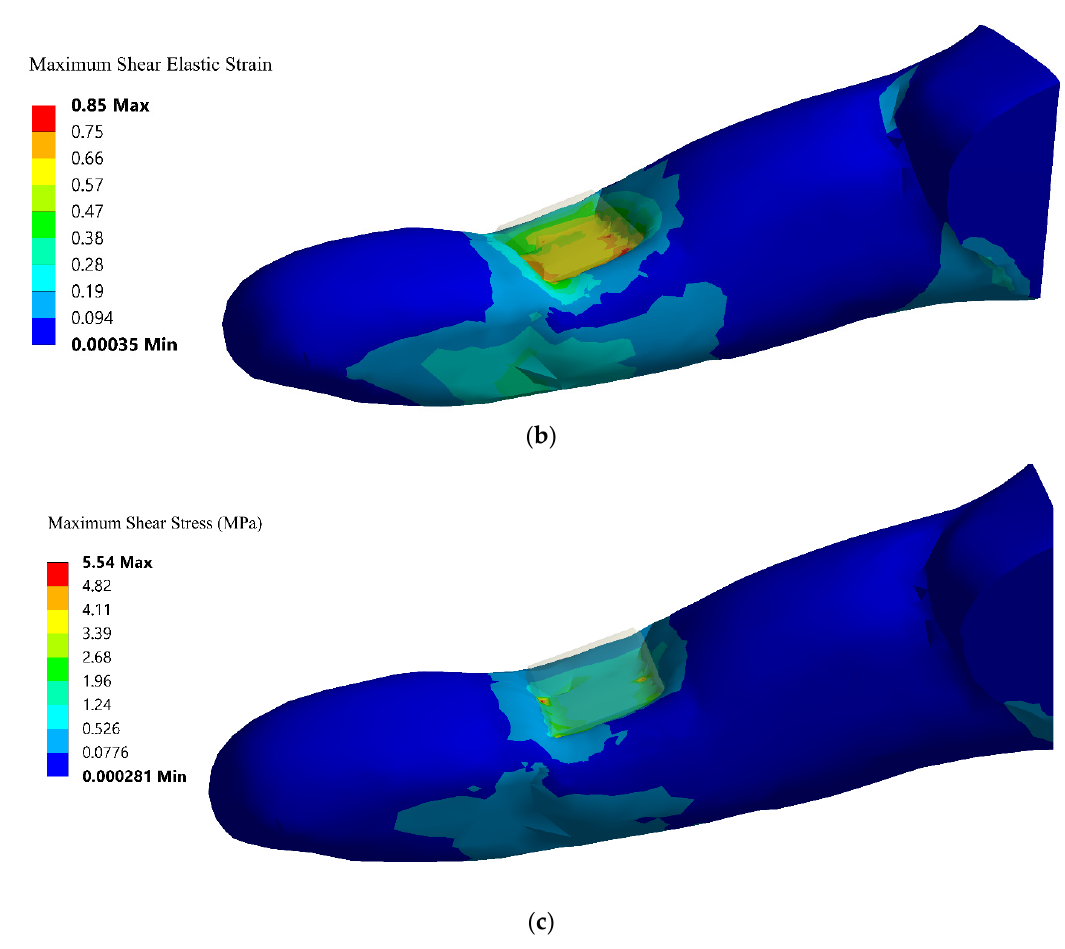
Figure 3. Quasi-Static test. ( a ) Maximum Principal Stress ( b ) Maximum Shear Elastic Strain ( c ) Maximum Shear Stress.